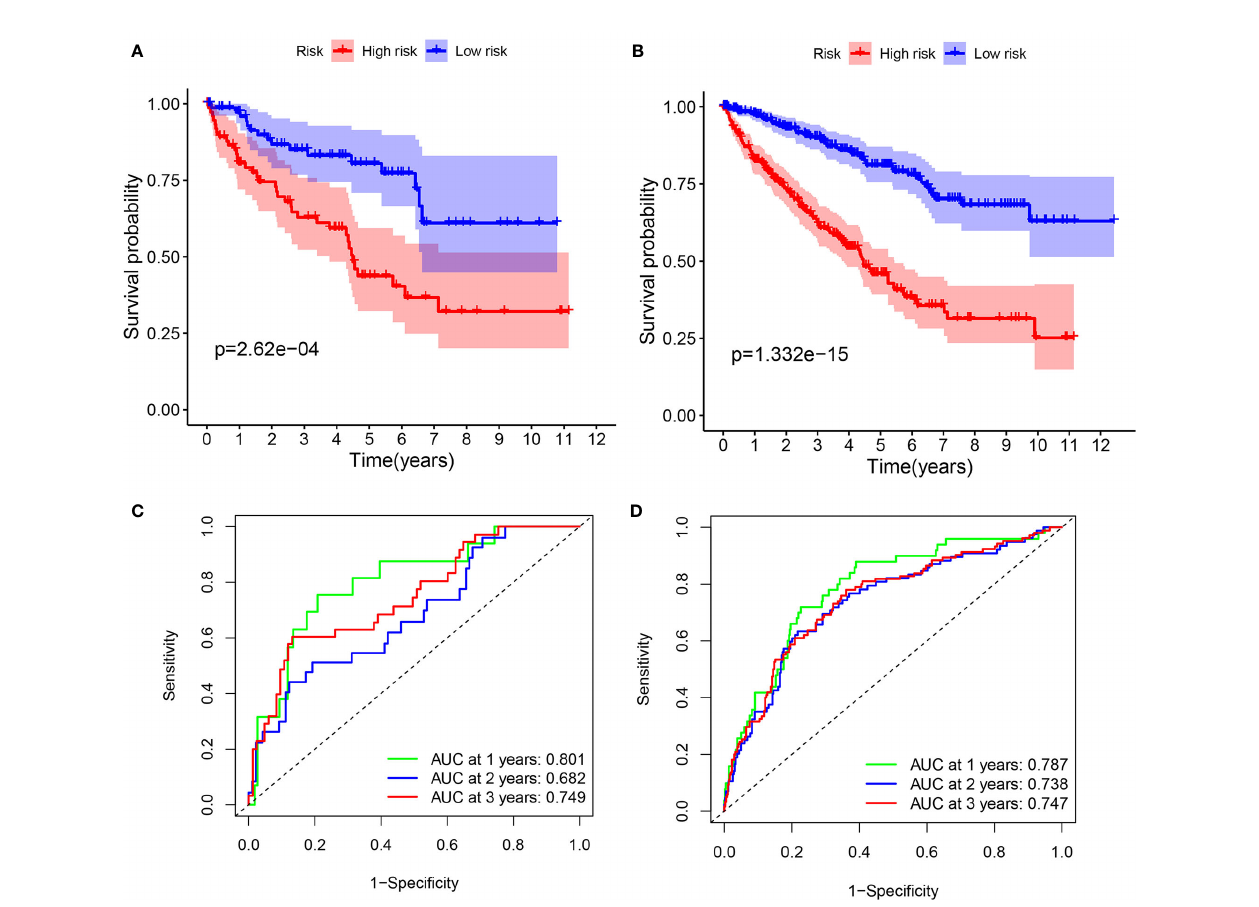
FIGURE 6 | Survival analyses in the validation cohorts. (A, B) Kaplan – Meier curve of the testing cohort (A) and the entire TCGA cohort (B) . (C, D) Time-dependent ROC curve of the testing cohort (C) and the entire TCGA cohort (D)